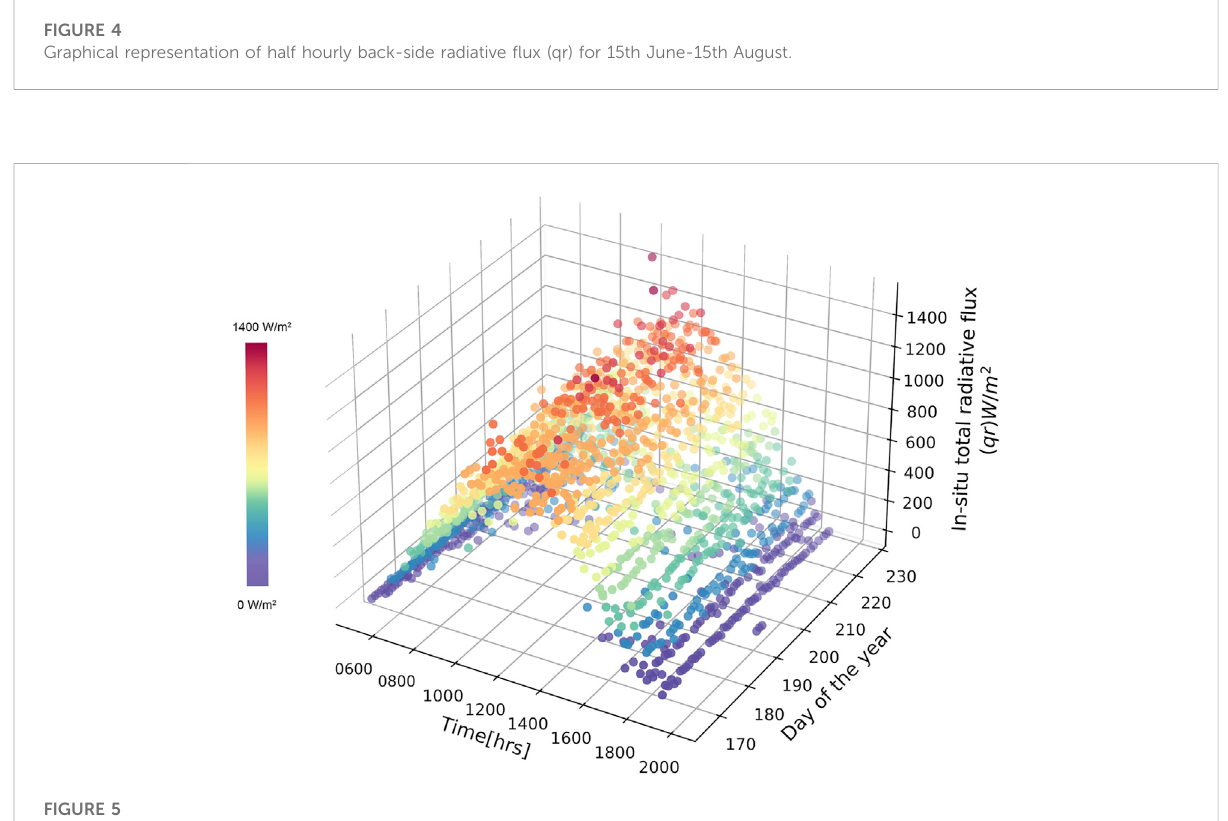
FIGURE 5 In situ total radiative fl ux